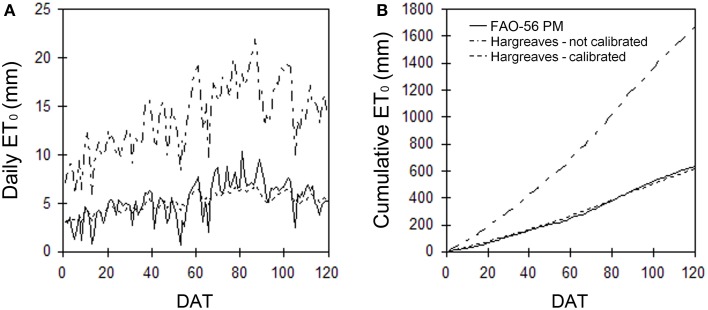
Example of Hargreaves over Penman-Monteith estimates as daily ET0-value or season cumulative ET0 before and after calibration.